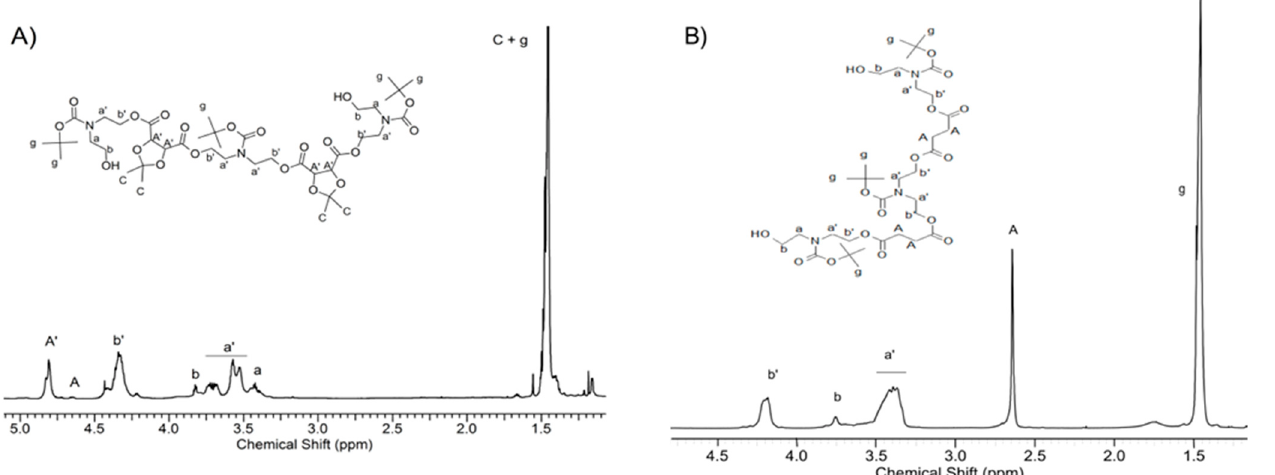
Figure 1. 1 H NMR spectra; ( A ) poly(tert-butyl-bis(2-hydroxyethyl) carbamate 2,3-O-isopropylidene-l-tartrate)—(Table 1, I2); ( B ) poly(tert-butyl-bis(2-hydroxyethyl) carbamate succinate)—(Table 1, I4). All obtained products were dissolved in chloroform, precipitated in diethyl ether, and then dried in a vacuum at 40 ◦ C to a constant